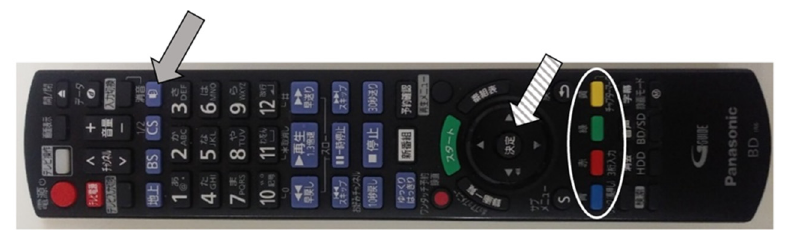
Figure 2. Television (TV) remote controller used in the Hybridcast TV system. Solid and dashed arrows indicate “d button” (data button) used to start the Hybridcast system and ‘enter’ button, respectively. Blue, red, yellow, and green colour buttons (white circle) can be used to answer four-choice questions.